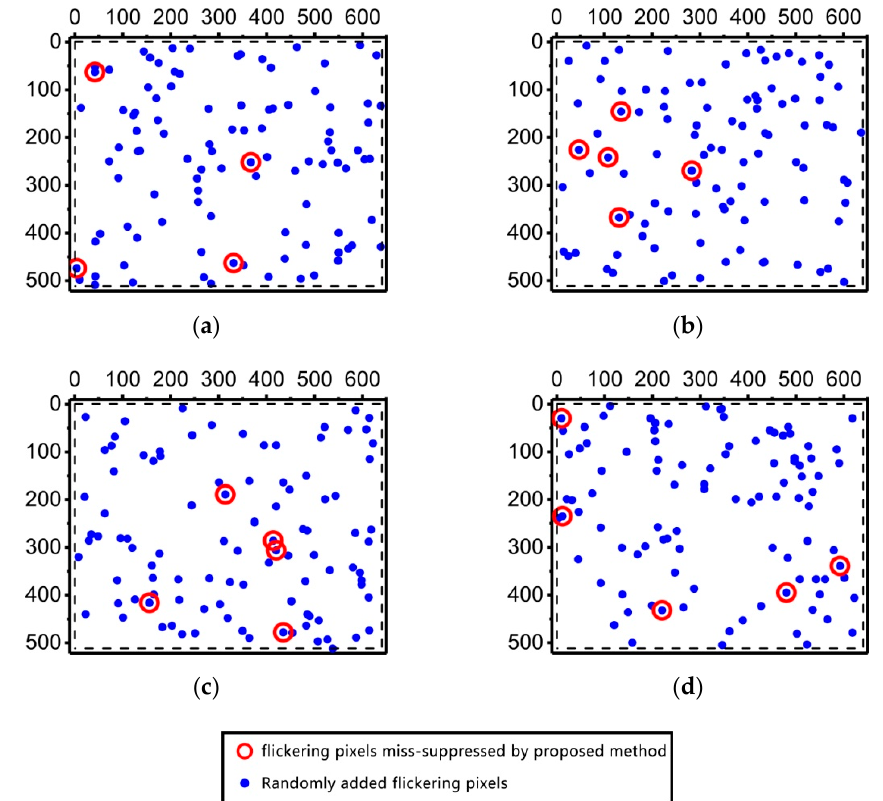
Figure 10. The randomly added flickering pixels and miss-suppressed flickering pixels of different scenarios ( a ) sky background; ( b ) sky background with IRPT; ( c ) deep space background; ( d ) deep space background with IRPT. Table 5. The situation of flickering pixels suppressed by proposed method.